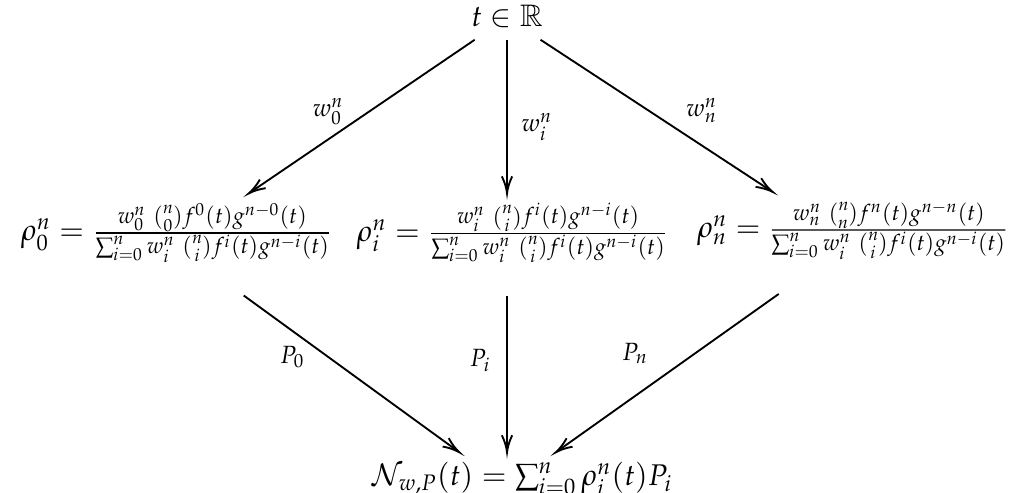
Figure 3. From top to bottom. The input layer has the parameter t ∈ R as input. The hidden layer is of width n + 1 and its parameters are the weights. Then, the output layer computes the approximation of the target curve and its parameters are the control points.